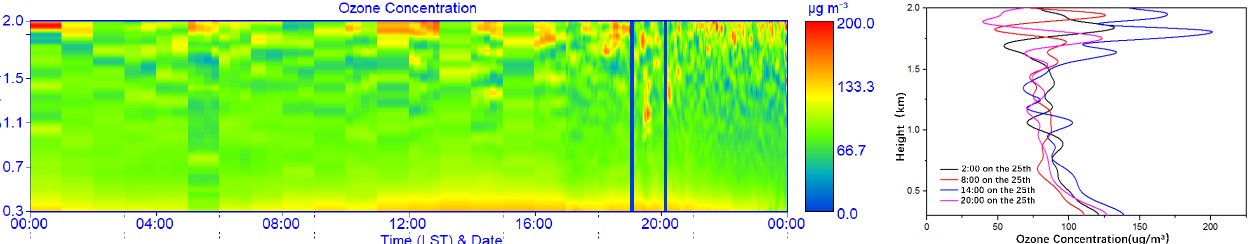
Figure 6. Ozone concentration distribution and corresponding spatial line on lidar on 25 May. Left: the changing trend of ozone concentration distribution and corresponding spatial line on lidar on 25 May; Right: ozone concentration vs. height.